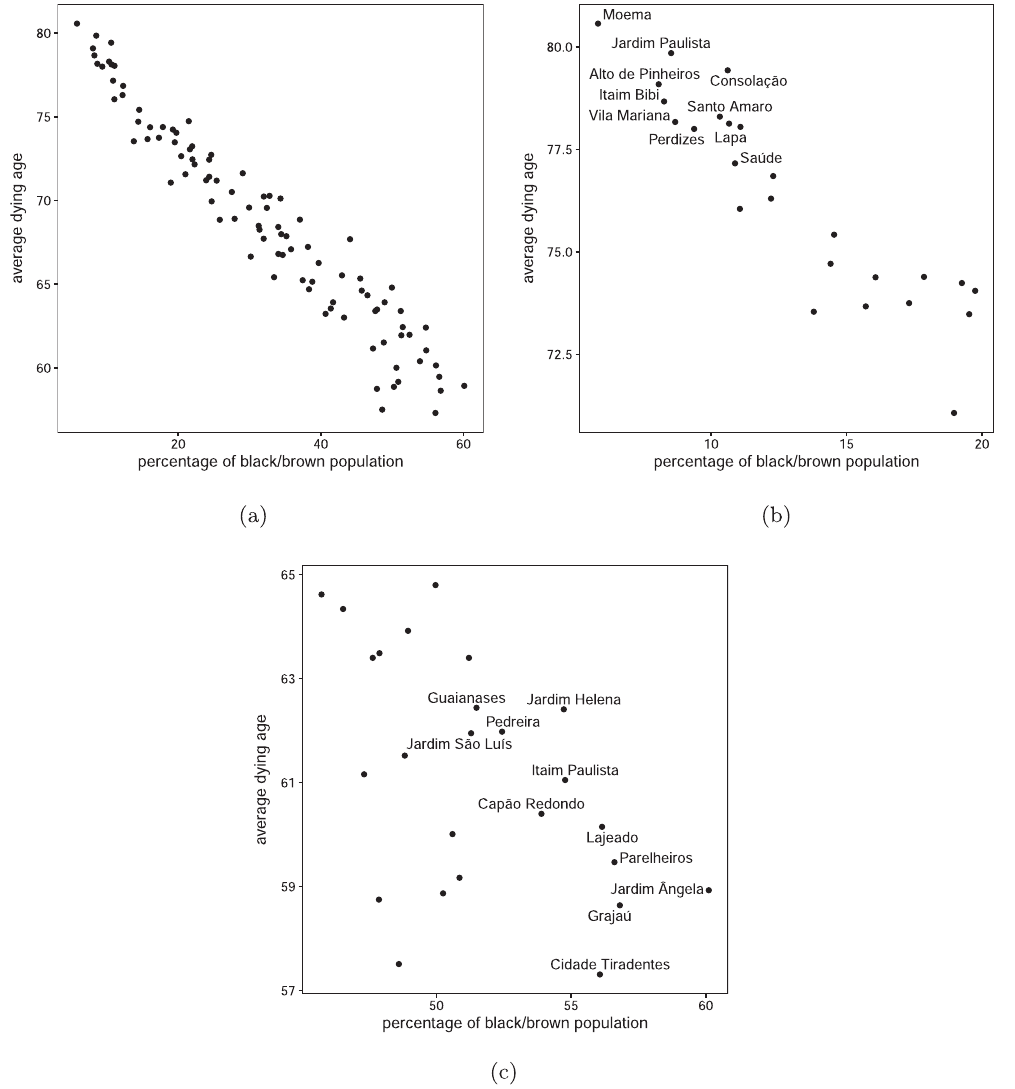
Figure 1. Dependence structure in the race inequality between neighbourhoods in São Paulo. (a) Scatter plot of observations. (b) The 25 cases with the highest proportion of white population. (c) The 25 cases with the highest proportion of black/brown